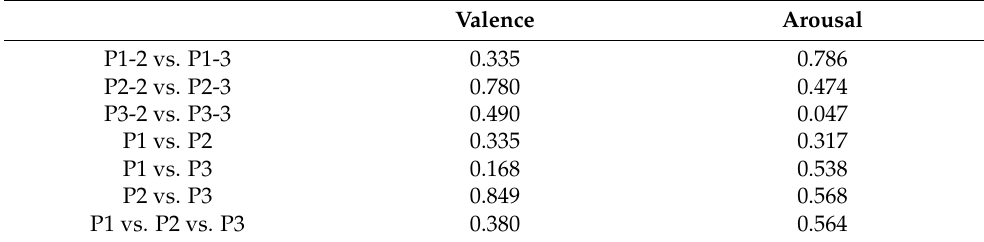
Table 3. SAM chi square test.